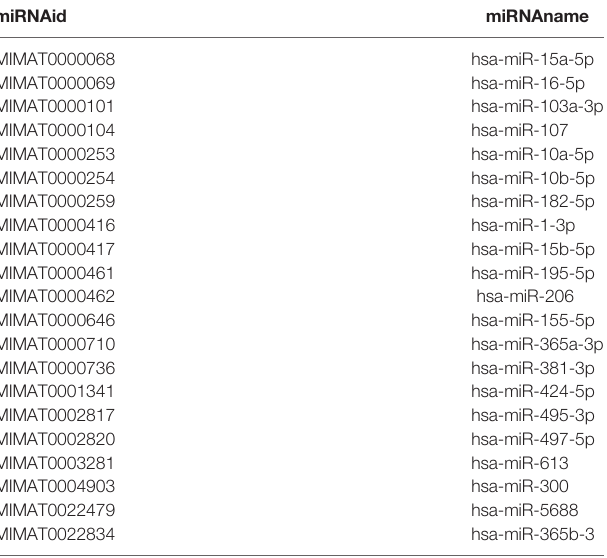
TABLE 3 | The list of primarily screened miRNAs that interact with BDNF by ENCORI. miRNAid